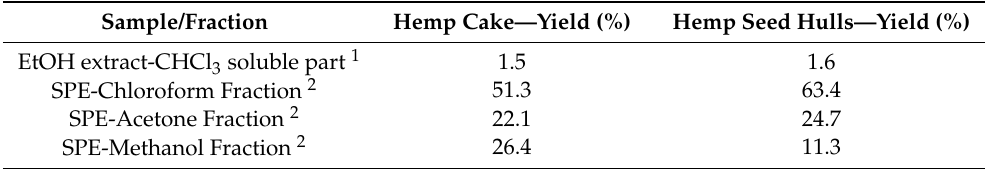
Table 1. Polar lipid fraction yield and solid phase extraction (SPE) of EtOH extract chloroform soluble fraction of hemp cake and hemp seed